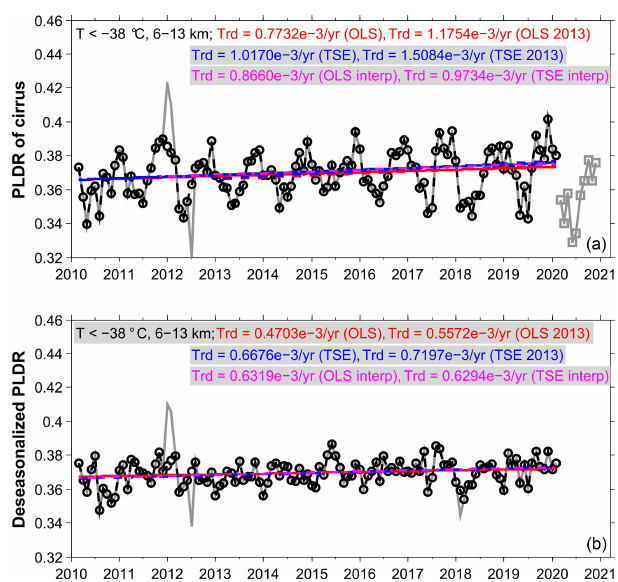
Figure 5. (a) Medians of cirrus PLDR in different months from March 2010 to February 2020 shown in grey lines and during the COVID-19 pandemic starting from March 2020 shown in squares. The results are derived from both day- and night-time lidar mea- surements of CALIPSO. Both OLS and TSE methods are applied to determine the long-term trends (i.e. slopes) of the cirrus PLDR (medians) and the results are indicated on the plot (see text for de- tails). (b) The long-term trends determined from the deseasonalized time series of cirrus PLDR